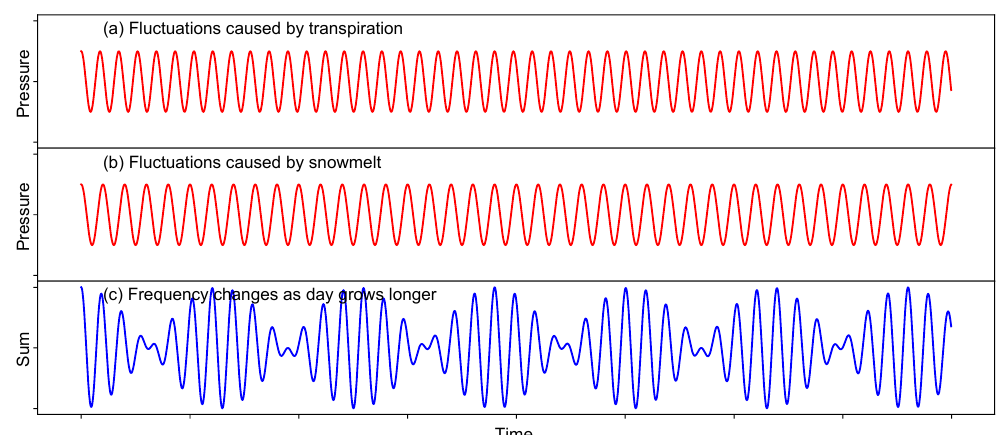
Figure 5. Additive interference of two sinusoidal pressure signals, one caused by transpiration (a) and other by snowmelt (b) , with slightly different frequencies. As the season advances and the days grow longer, the frequencies of transpiration and snowmelt will change. The resulting signal (c) is the sum of both waves. The amplitude of the envelope of the resulting signal is sinusoidal with a frequency determined by half the difference of the frequency of the individual signals. Compare with Fig. 3.